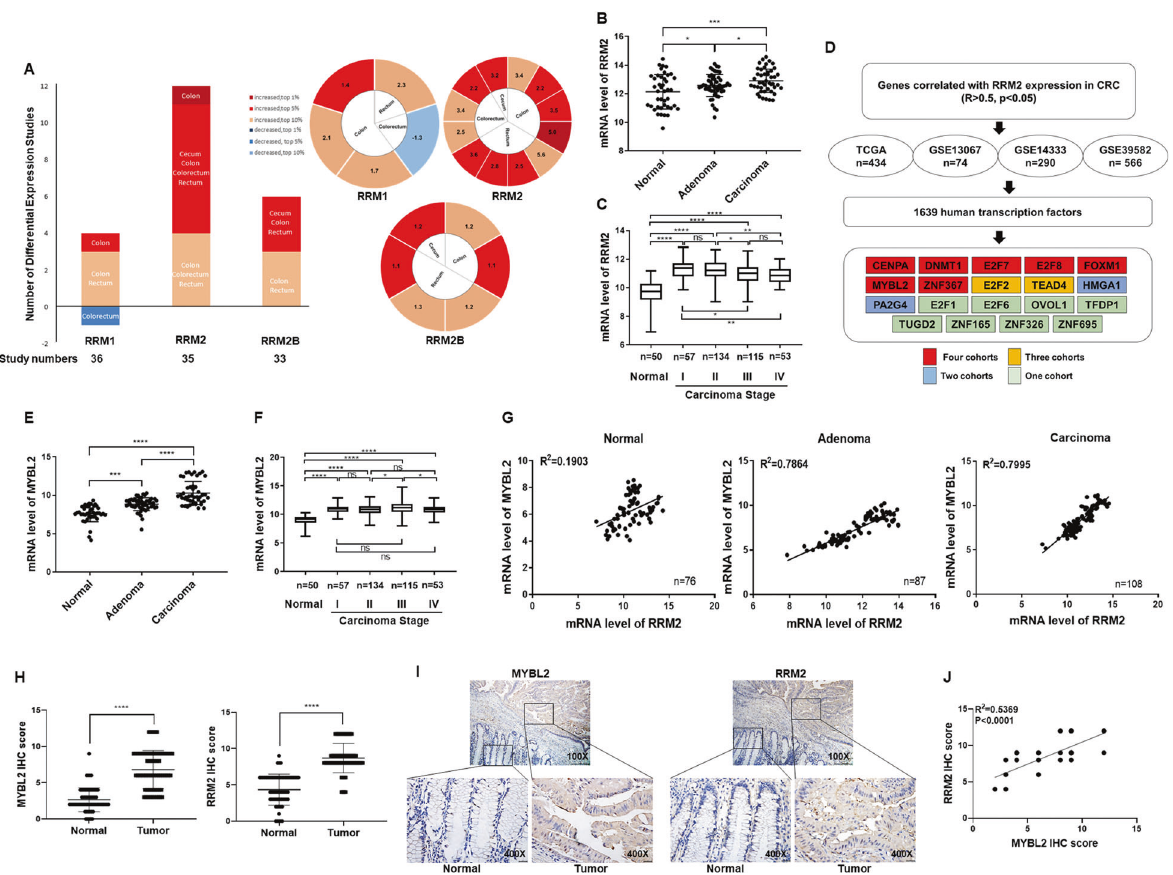
Fig. 1 MYBL2 expression was upregulated in parallel with RRM2 level in clinical CRC patient samples. A The mRNA expression pro fi les (left) and the fold changes (right) of RRM1, RRM2, and RRM2B in CRC. All mRNA expression data of three RR subunit genes in CRC were downloaded from Oncomine database. DEGs were screened by “ data type = mRNA, concept fi lter = cancers vs. normal, P < 0.05. ” The y -axis of left panel presented the number of studies in which RRM1, RRM2, and RRM2B were differentially expressed according to the criteria. Fold changes shown in the color cells of the right panel were calculated by “ cancer vs. normal ” from the differentially expressed studies in the left panel. Dark red represented cancers in which the interested gene had a gene rank of the top 1% in the elevated-expression of the DEGs, and red and brick red marked top 5%, or 10%, respectively, while dark blue, blue, and light blue colors marked the top 1, 5, and 10% in the decreased-expression of the DEGs, respectively. Gene rank: genes are ranked by the p -value list. B, C The increased mRNA expression of RRM2 during CRC development. The mRNA expression data and clinicopathological information of CRC patients were downloaded from GSE20916 ( B ) and TCGA ( C ), respectively. D Screening of RRM2-correlated transcription factors (TFs). The expression correlation between RRM2 and all other genes in four CRC cohorts was measured by Pearson correlation coef fi cient. The human TFs that were positively correlated with RRM2 expression (R > 0.5, p < 0.05) were selected and listed in alphabetical order. E, F The increased mRNA expression of MYBL2 during CRC development. The mRNA expression data and clinicopathological information of CRC patients were downloaded from GSE20916 ( E ) and TCGA ( F ), respectively. G The expression correlation between MYBL2 and RRM2 in colorectal normal, adenoma, and carcinoma tissues, respectively. The mRNA expression data and clinicopathological information of CRC patients were downloaded from GEO (GSE20916, GSE8671, and GSE35896). H The protein expression level of MYBL2 and RRM2 determined by IHC in the paired cancer and adjacent normal tissues from 69 CRC patients. I Representative IHC images of MYBL2 and RRM2 in the CRC and adjacent noncancerous tissues (consecutive sections). Scale bars: 200 μ m (100×), 25 μ m (400×). J The correlation of IHC scores between MYBL2 and RRM2 in the 69 CRC tissues. ns, not signifucant; * p < 0.05; ** p < 0.005, *** p < 0.001, **** p <